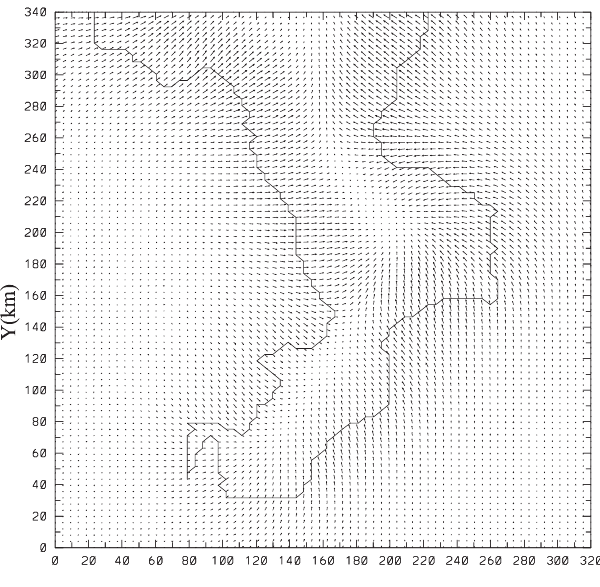
Fig. 10. As in Fig. 8 but for the ; v G (cid:136) 0 : 5 m ; b (cid:136) 2 K s s km